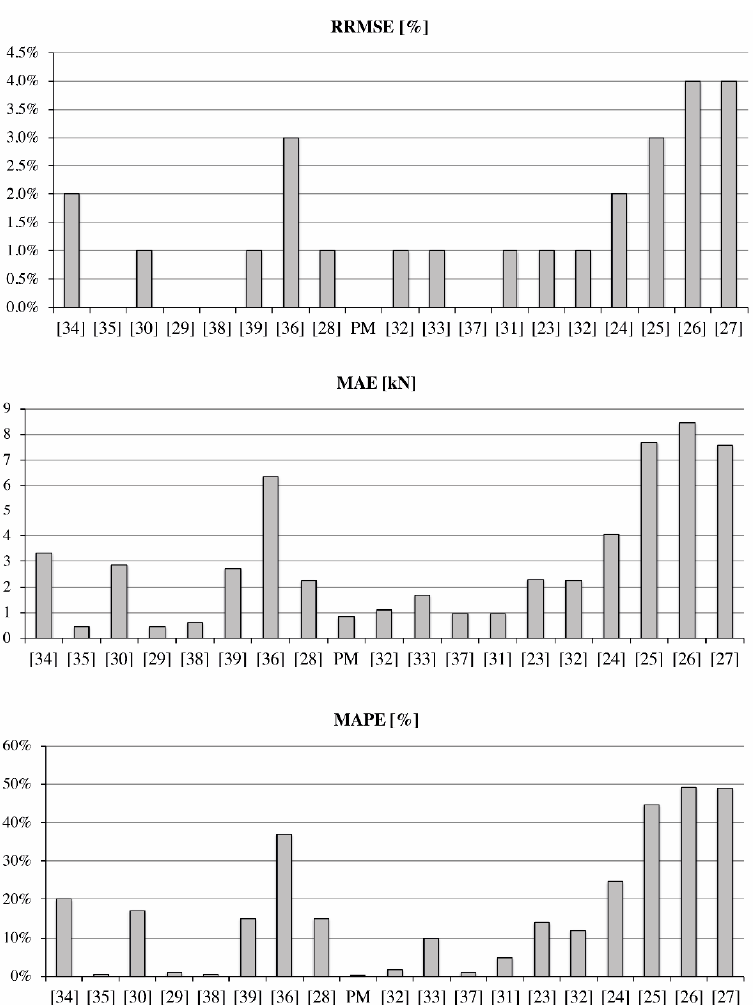
Figure 14. Statistical coefficients: RRMSE ( top ), MAE ( middle ) and MAPE ( bottom ).